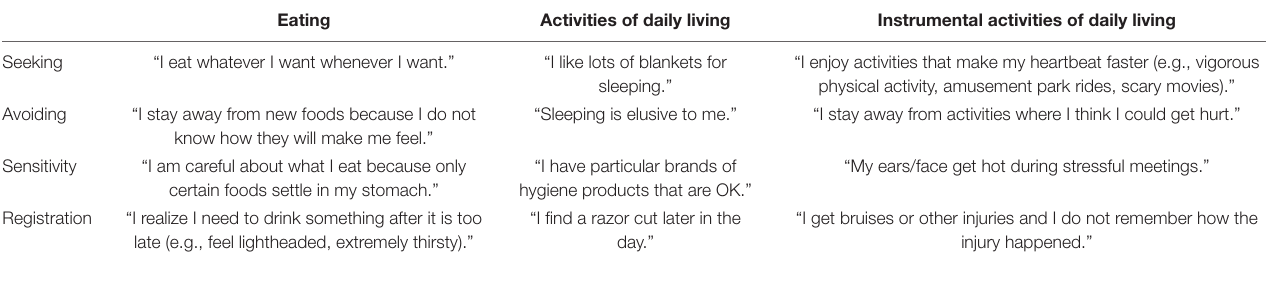
TABLE 1 | Examples of items from the Sensory Profile Interoception